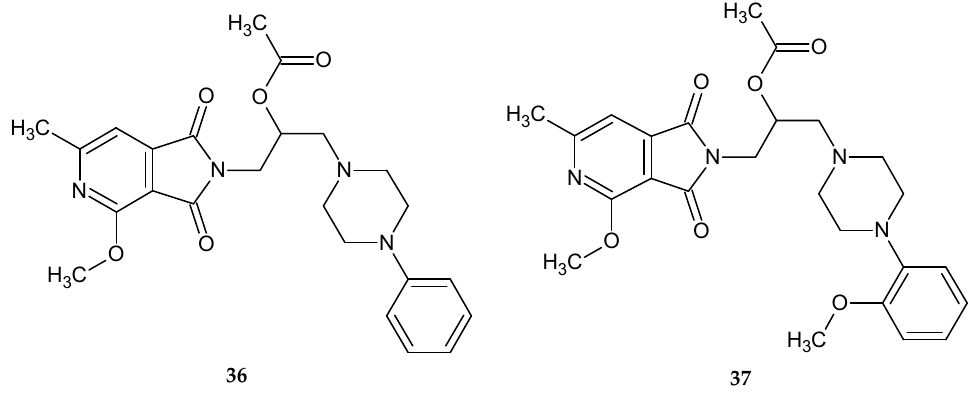
Figure 29. Derivatives of 1 H ‐ pyrrolo[3,4 ‐ c ]pyridine ‐ 1,3(2 H ) ‐ diones 36 and 37 .